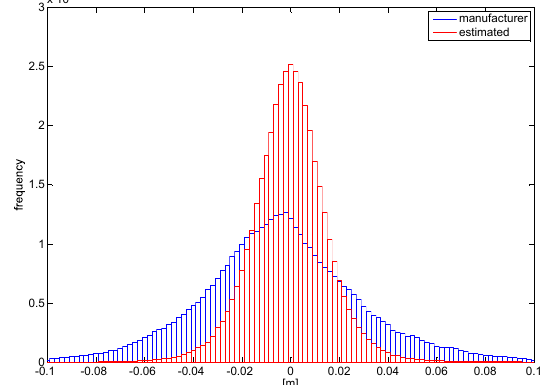
Figure 6: Histogram of the distance residuals plotted in the range of − 0 . 15 m to 0 . 15 m.